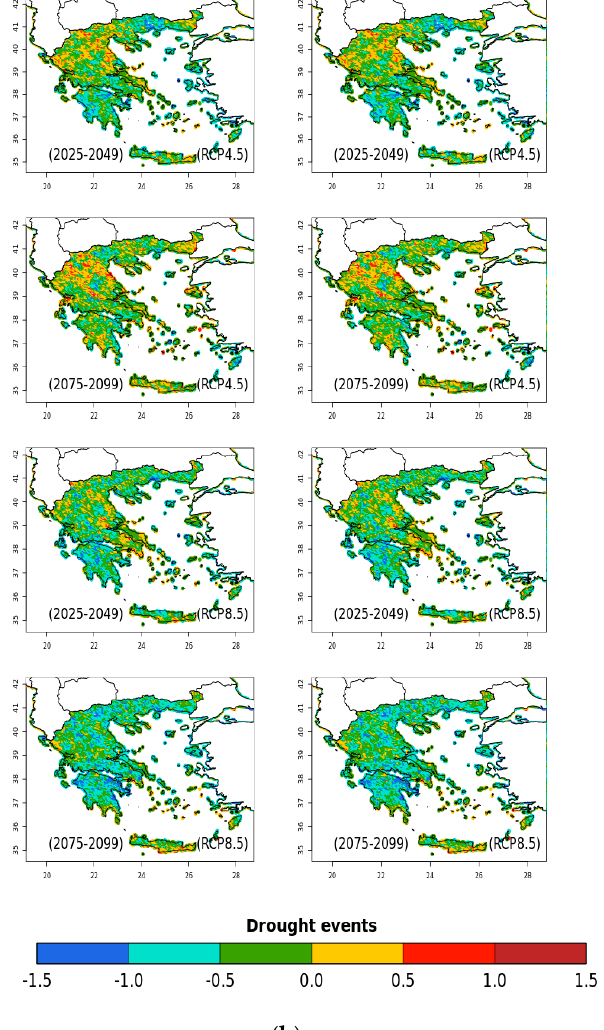
Figure 10. ( a ) Drought frequency as the number of events in 25 years for the reference period (1980–2004) for the SPI and the SPEI indices computed at a 12-month timescale. ( b ) Changes in the frequency for the 12-month SPI and SPEI for the near future period (2025–2049) and the far future (2075–2099) relative to the reference period (1980–2004) under RCP4.5 and RCP8.5.